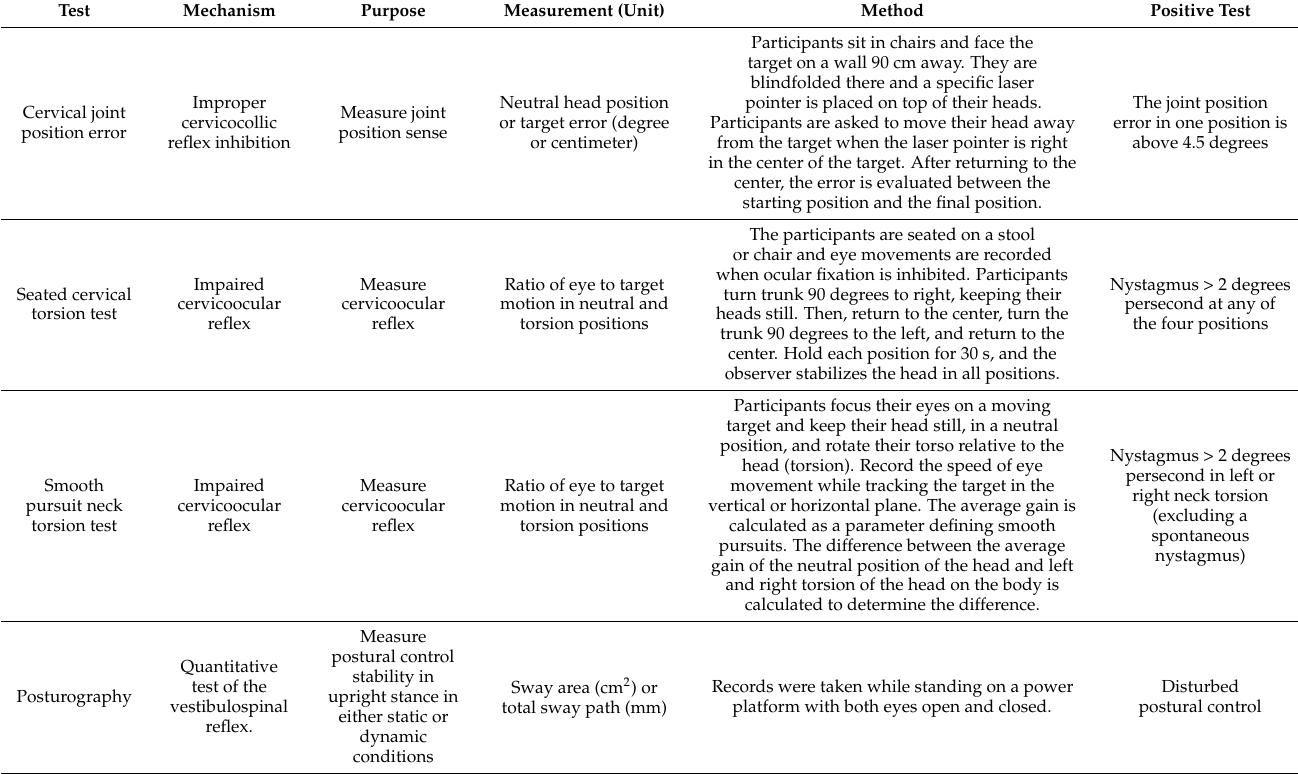
Table 3. Diagnostic tests for cervicogenic